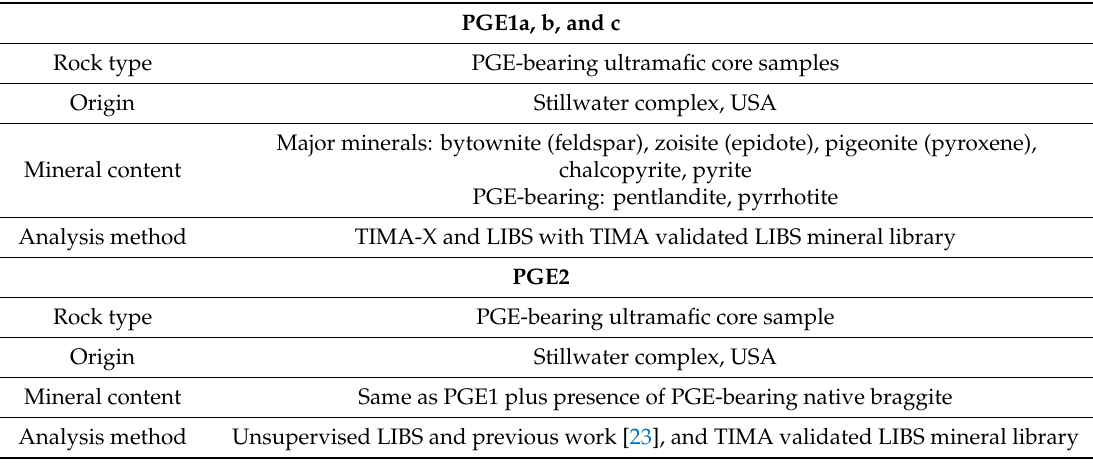
Table 1. Geological information on the PGE1 and PGE2 core